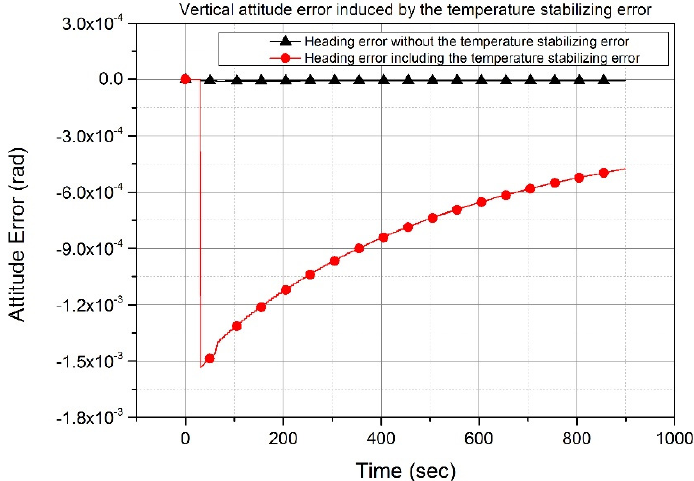
Figure 6. Heading errors depending on the temperature stabilizing error. Temperature stabilizing error induces exponentially decreasing heading error, which is greater than the horizontal attitude error in Figure 5.